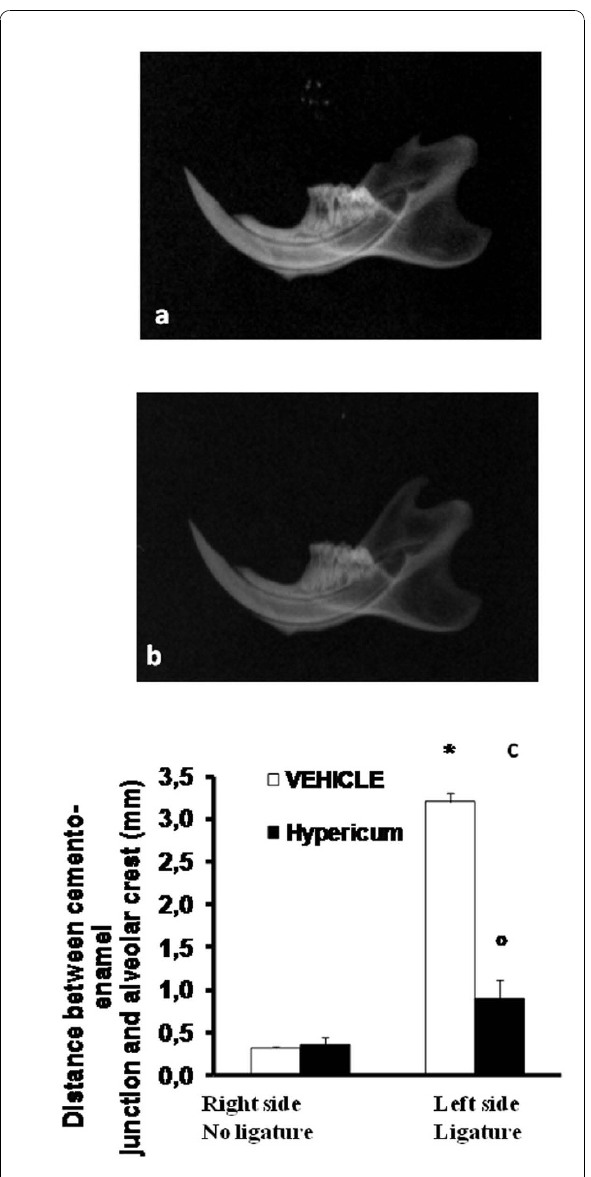
Figure 2 The alveolar bone from ligated (8 days) rats demonstrated alveolar bone resorption (a) . Hypericum treatment suppressed alveolar pathology in the rat alveolar bone (b). A significant increase in the distance between cemento-enamel injunction and alveolar crest at mediolingulal root of the first molar was observed in ligature-treated rats (c). Hypericum treatment significantly reduced the increase in the distance between cemento-enamel injunction and alveolar crest (c). Radiographic figure is representative of at least 3 experiments performed on different experimental days. Data represent the data from 20 counts obtained from the gingivomucosal tissue of each treatment group. *P < 0.01 vs. non-ligated; °P < 0.01 vs.